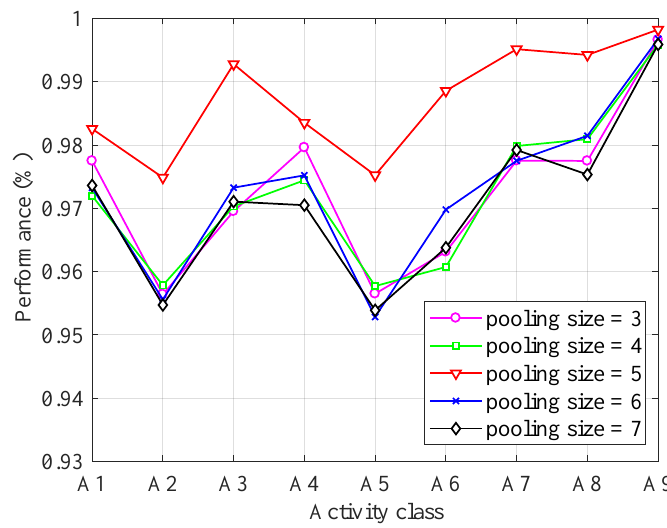
Figure 5. The performance with different pooling size.